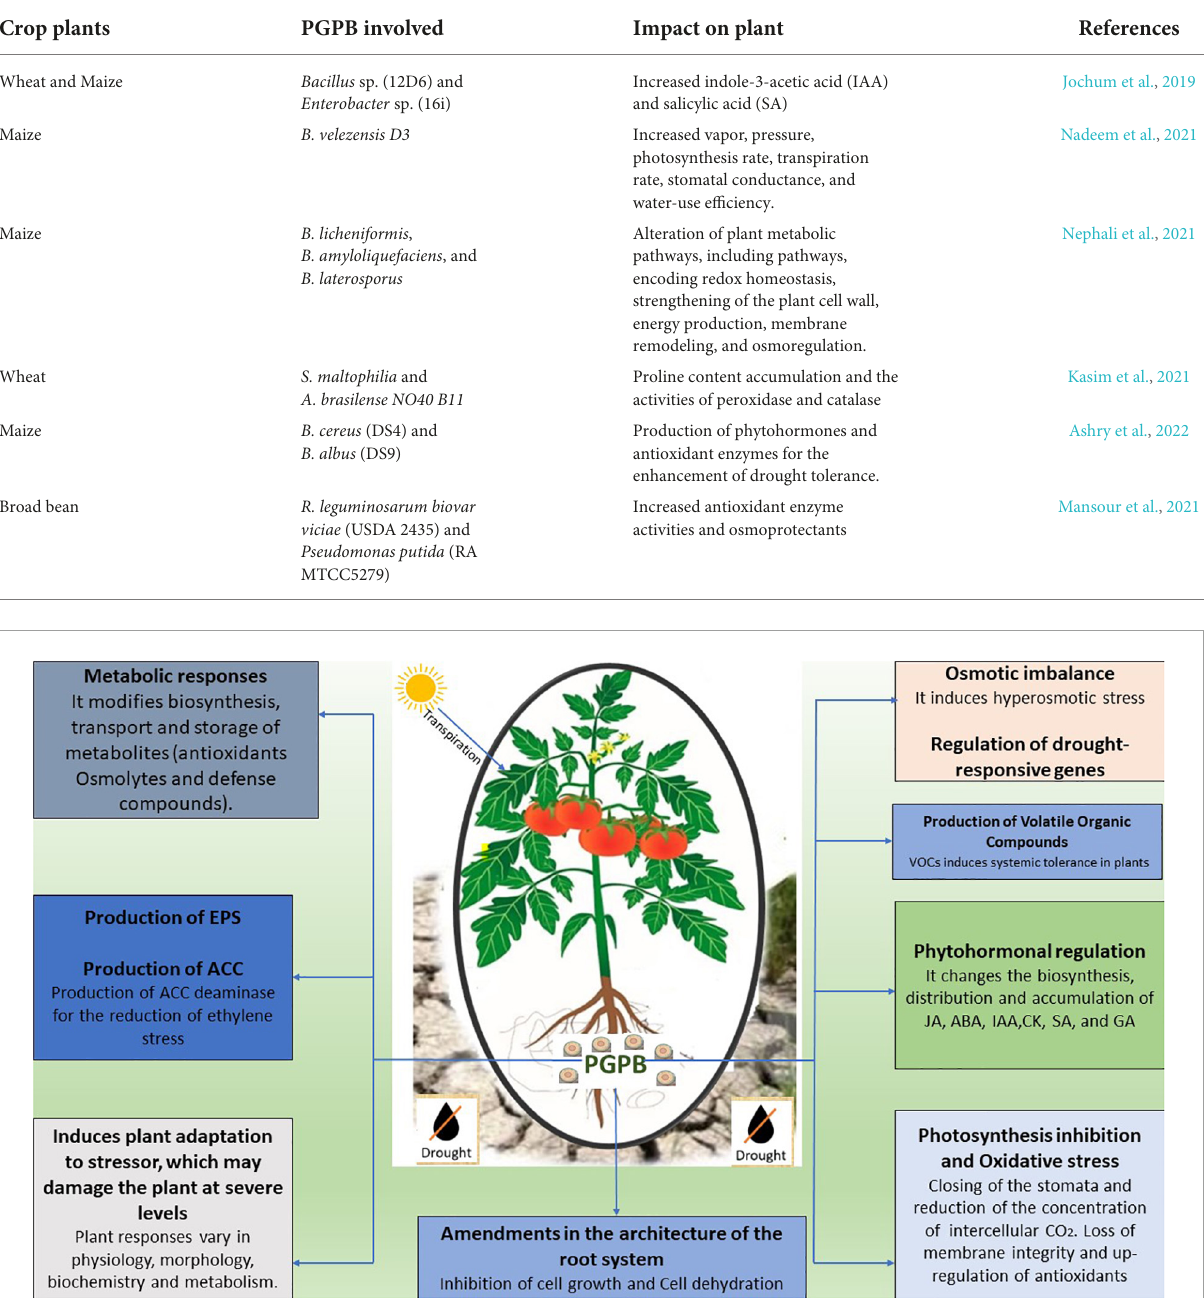
FIGURE2 A diagrammatic representation of different potential mechanisms employed by PGPB in the amelioration of drought stress in crops.